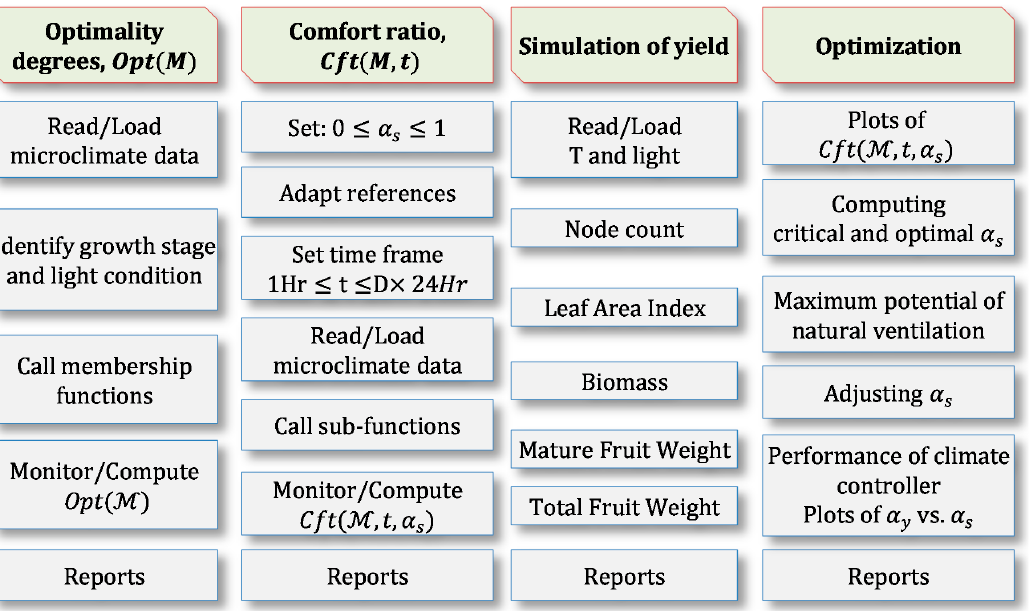
Figure 6. Screenshot of the adaptive management framework toolbox used for sensor fusion [17] .